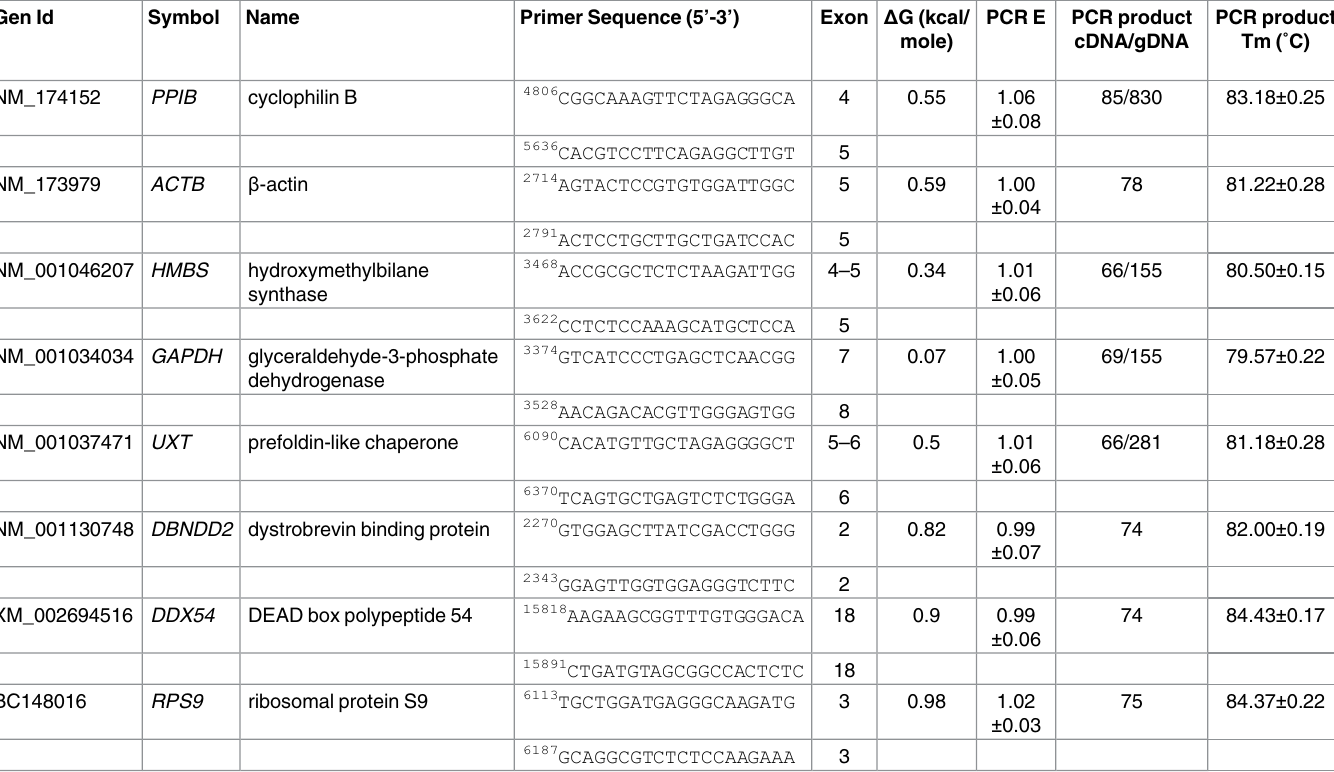
Table 1. Description of referencegenes and primer sequences. Primer PCR efficiency and PCR Tm product data represent mean values ± SE (n = 30). PCR efficiencies(E) calculatedaccordingto the equation(1 + E) = 10 slope . Free energy for potentialsecondary structures in the ampliconis shown ( Δ G, kcal/